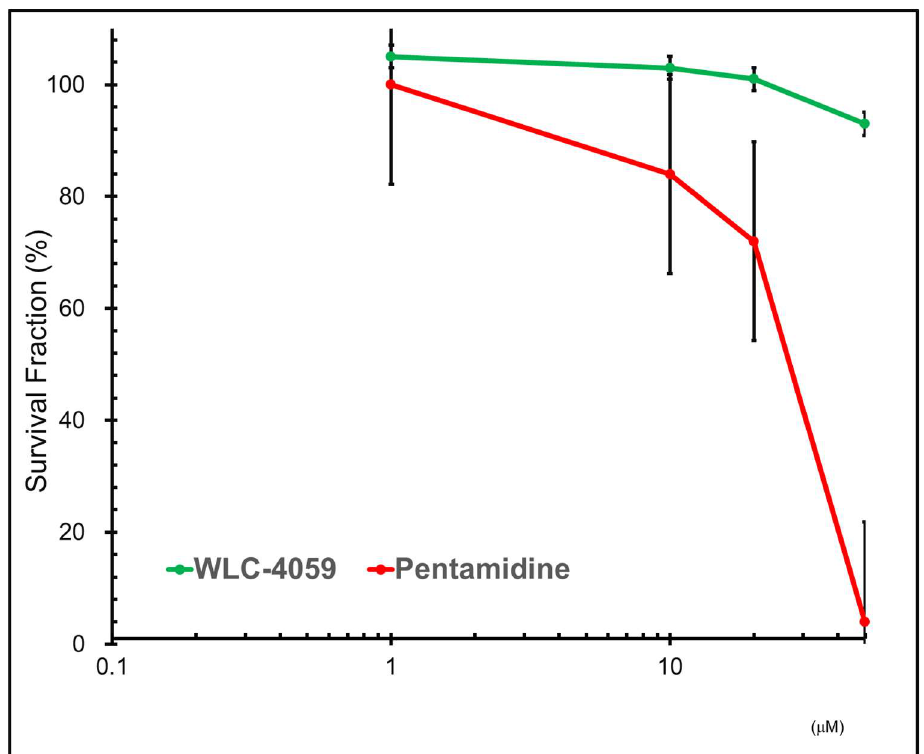
Figure 6. WST-1 assay analysis of cytotoxicity: results of cytotoxicity of pentamidine (shown in red) and pentamidine derivative (WLC-4059) (shown in green). Cells were treated with increasing concentrations (0, 1, 10, 20, and 50 µM) of pentamidine and the pentamidine derivative (WLC-4059).